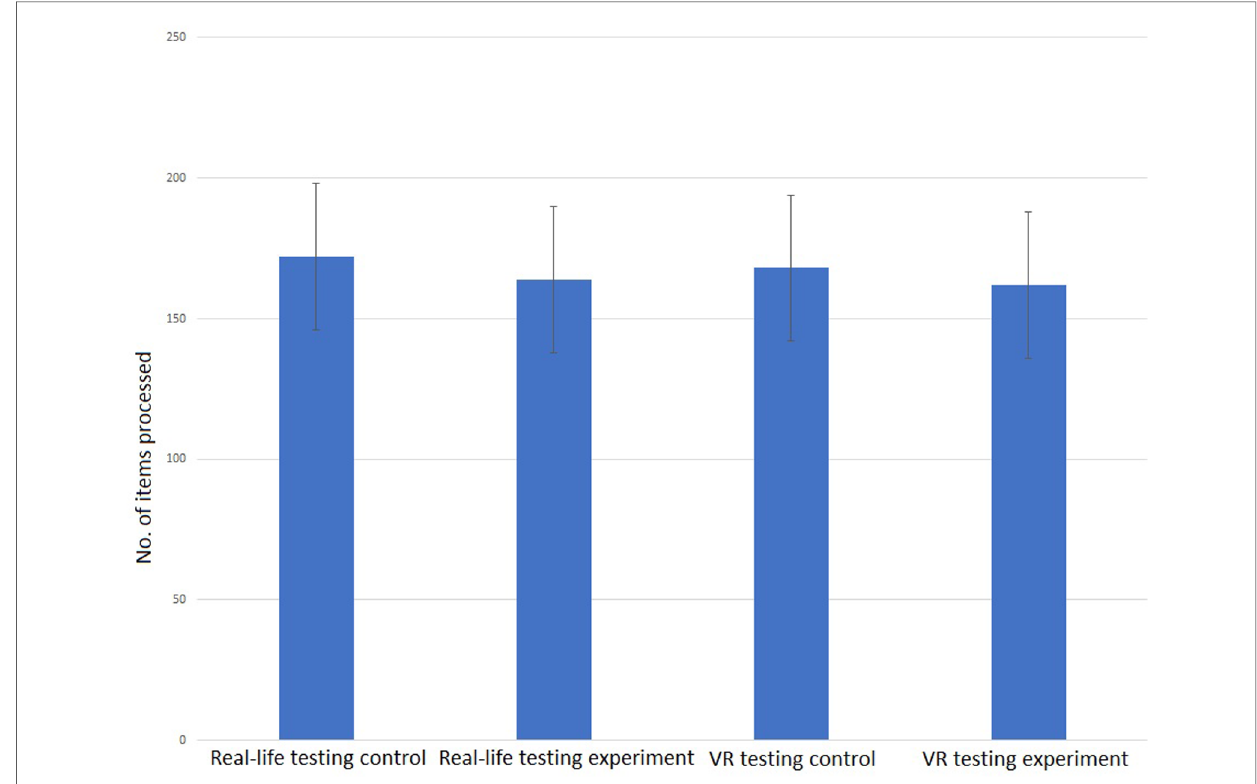
FIGURE 5 Mean No. of items processed during the whole D2-behaviourial test in control and experimental condition (real-life testing left [172 items, SD 26 vs. 164 items, SD 25, t (8)=2.17, p =0.062]; VR-testing right [168 items, SD 18 vs. 162 items, SD 14, t (7)=1.97, p =0.081]. No statistically signi fi cant differences between the conditions could be